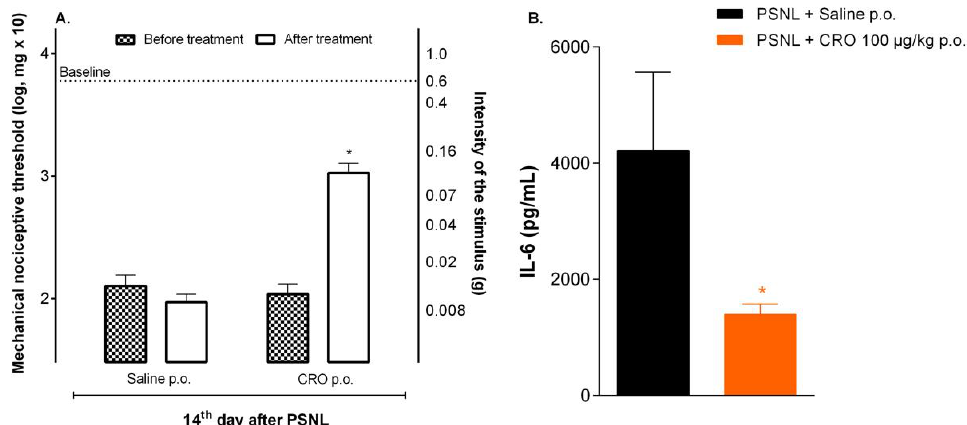
Figure 5. Spinal IL-6 levels after crotalphine treatment in mice underwent partial sciatic nerve injury (PSNL) surgery. On the 14th day after PSNL surgery, mice were treated with crotalphine (CRO) p.o., and after nociceptive threshold evaluation ( A ) the spinal cord was collected and processed and IL-6 levels was measured in the supernatant by enzyme immunoassay (ELISA) ( B ). Results represent the group mean ( ± SEM). n = 5–6. * p < 0.05 indicates a statistically significant difference in relation to the group PSNL + Salina p.o. The one-way ANOVA test was used followed by Tukey’s test.